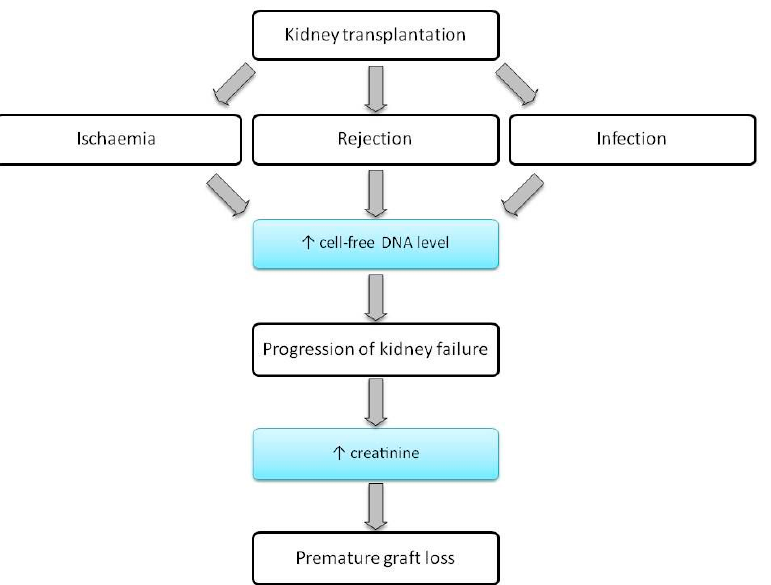
Figure 3. A flow chart showing the progression from KTx to premature graft loss. cfDNA may be